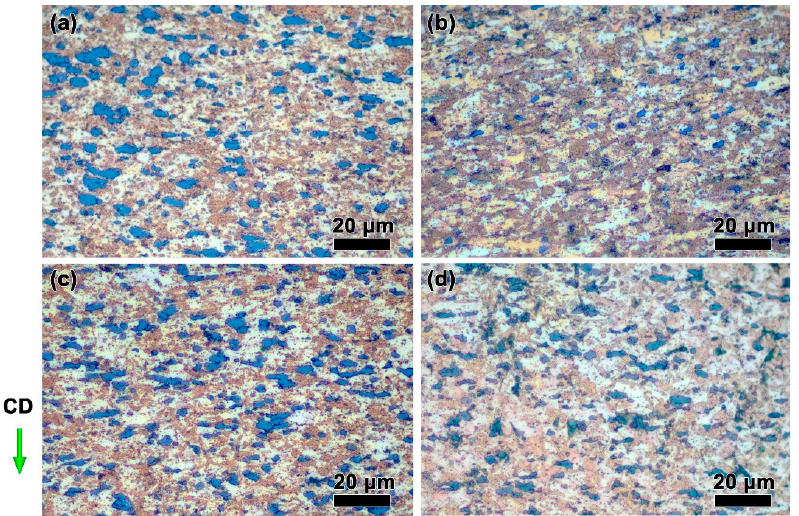
Figure 4. Microstructures of the ZnSnO 3 /Cu composites at 0.01 s − 1 strain rates with different temperatures: ( a ) 650 ◦ C, ( b ) 700 ◦ C, ( c ) 750 ◦ C, and ( d ) 800 ◦ C. CD presents the compression direction of the sample.